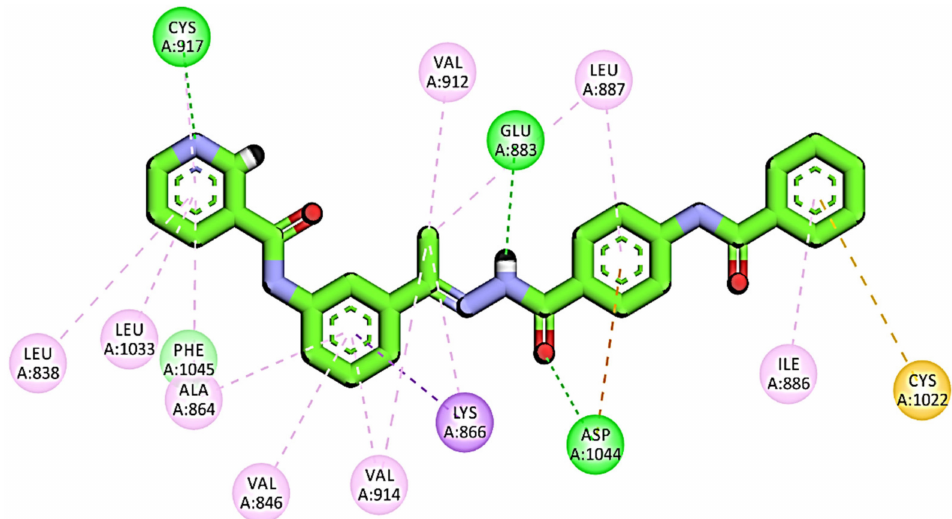
Figure 5. Mapping surface, 3D and 2D representation of compound 10 showing its interaction with the VEGFR-2 active site.